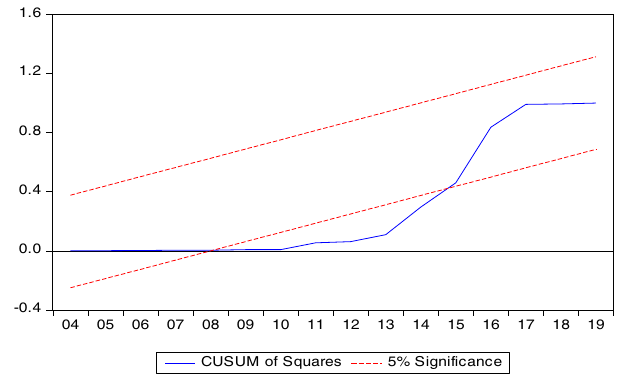
Fig. 2 Break point determined by CUSUM of Squares test. Authors ’ own calculation based on NCRB